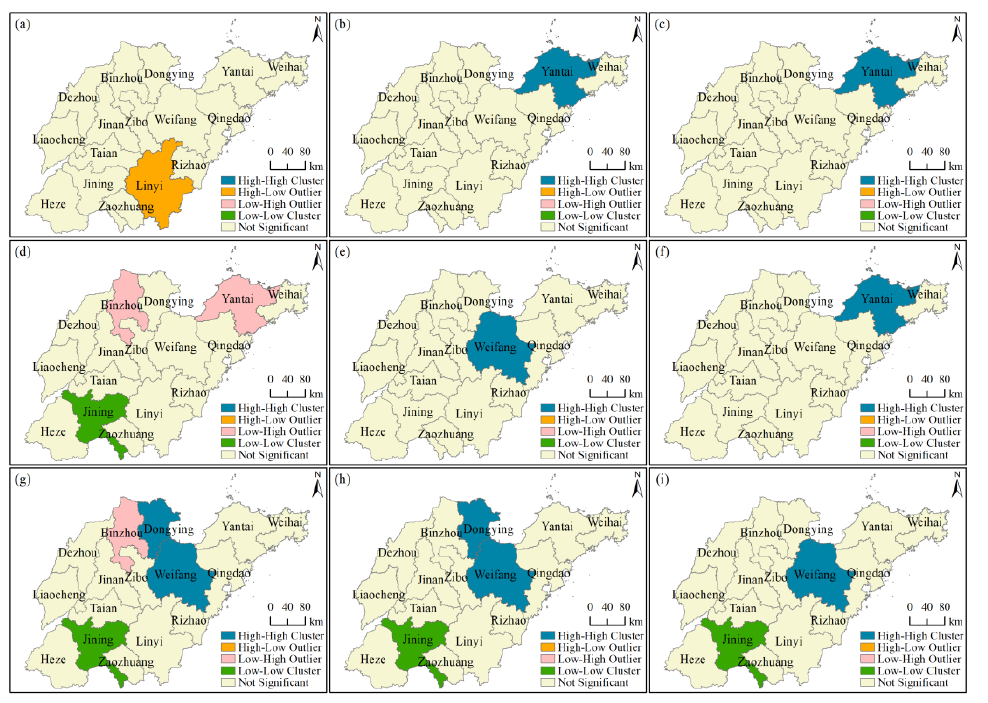
Figure 8. LISA agglomeration map of carbon emissions in Shandong Peninsula urban agglomera- tion. ( a ) Total carbon emissions in 2000; ( b ) total carbon emissions in 2010; ( c ) total carbon emissions in 2019; ( d ) land-average carbon emissions in 2000; ( e ) land-average carbon emissions in 2010; ( f ) land-average carbon emissions in 2019; ( g ) carbon emissions per capita in 2000; ( h ) carbon emissions per capita in 2010; ( i ) carbon emissions per capita in 2019.